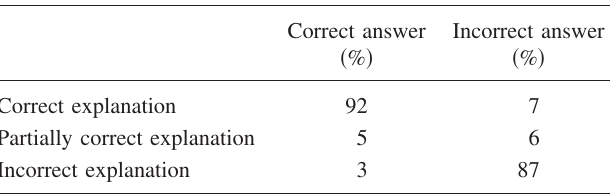
TABLE VI. A cross tabulation of 104 students’ written explana- tions and correct or incorrect classified multiple-choice answers.